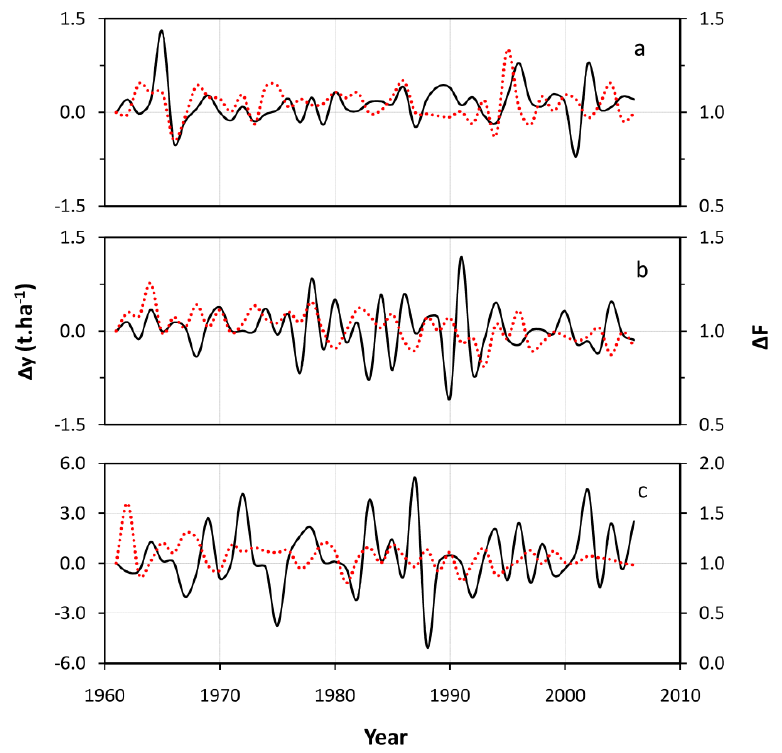
Figure 5. Year to year changes in crop yield ( ∆ y ; solid line) and in total fertilizer consumption ( ∆ F ; dotted line). For a better visualisation, ∆ y and ∆ F are expressed as the difference and the ratio between values of two consecutive years, respectively. Panels ( a ), ( b ) and ( c ) refer to maize-Egypt, wheat-Greece and potato-Morocco,